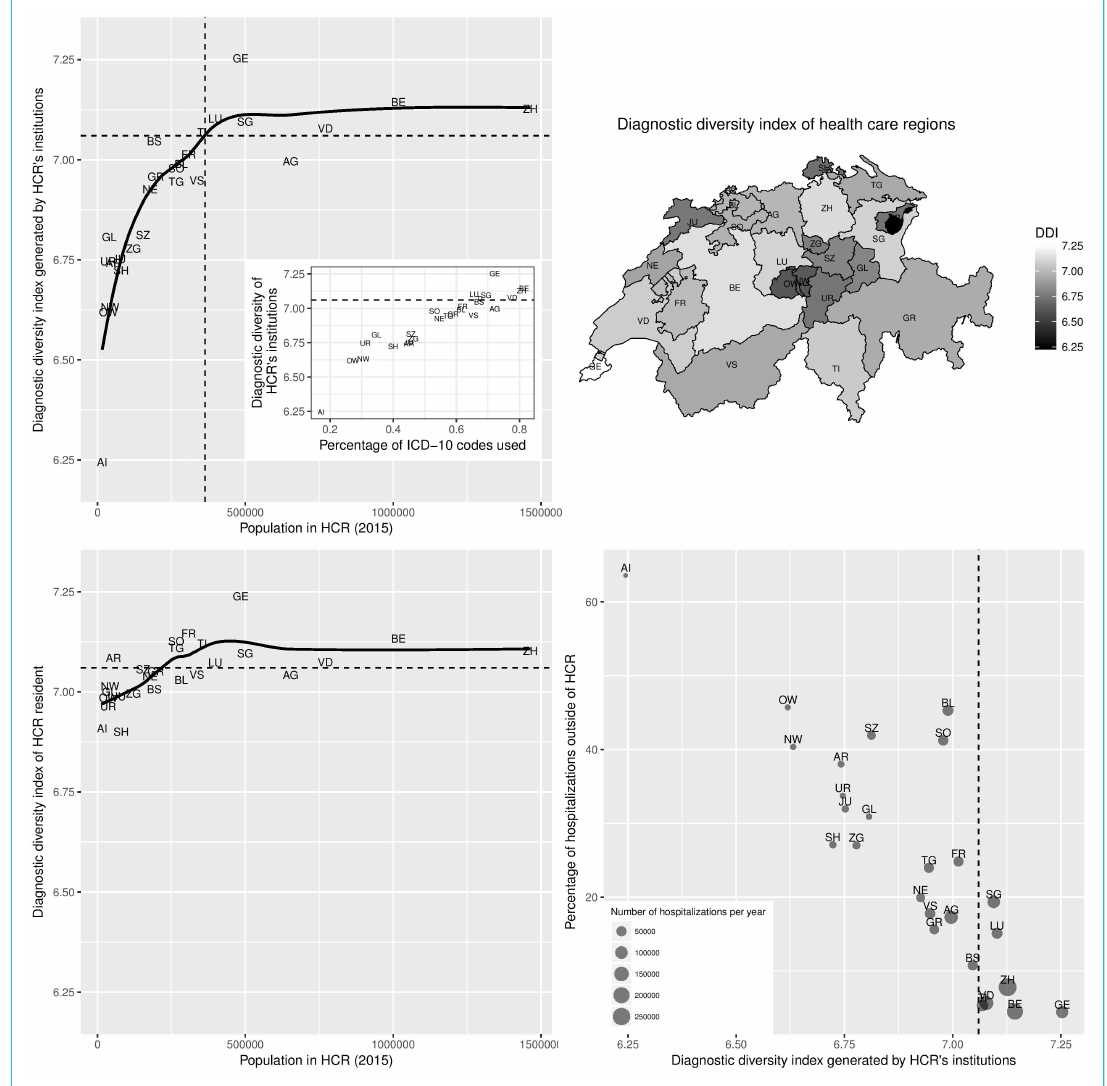
Figure 5: Diagnostic diversity index (DDI) in Swiss health care regions. The upper left panel displays the relationship between the size of the healthcare region (population) and the diagnostic diversity index generated by healthcare regions’ institutions (inset including the represen- tation of the diagnostic diversity as a function of the percentage of ICD-10-GM codes used). The minimum clinically important difference (MCID) of 10% misdiagnosis is represented using a dashed line. The intersection point where the MCID 10% misdiagnosis and the loess re- gression curve cross defines the cut-off of sufficient diagnostic diversity. In general, health care regions with a population size >363,522 were likely to have an adequate DDI. The upper right panel provides choropleth representation of the DDI generated by the institutions of each healthcare region. The lower left panel shows the relationship between the size of the healthcare regions (population) and the DDI of the re- gion’s residents. The lower right panel depicts the relationship between the DDI generated by healthcare region’s institutions and the percent- age of hospitalisation outside of health care regions. The dashed line represents the DDI threshold of 10% misclassification. The health care regions (Swiss cantons) are coded as follows: AG = Aargau; AI = Appenzell Innerrhoden; AR = Appenzell Ausserrhoden; BE = Bern; BL = Basel-Landschaft; BS = Basel-Stadt; FR = Fribourg; GE = Geneva; GL = Glarus; GR = Graubünden; JU = Jura; LU = Luzern; NE = Neuchatel; NW = Nidwalden; OW = Obwalden; SG = St. Gallen; SH = Schaffhausen; SO = Solothurn; SZ = Schwyz; TG = Turgau; TI = Ticino; UR = Uri; VD = Vaud; VS = Valais; ZG = Zug; ZH =